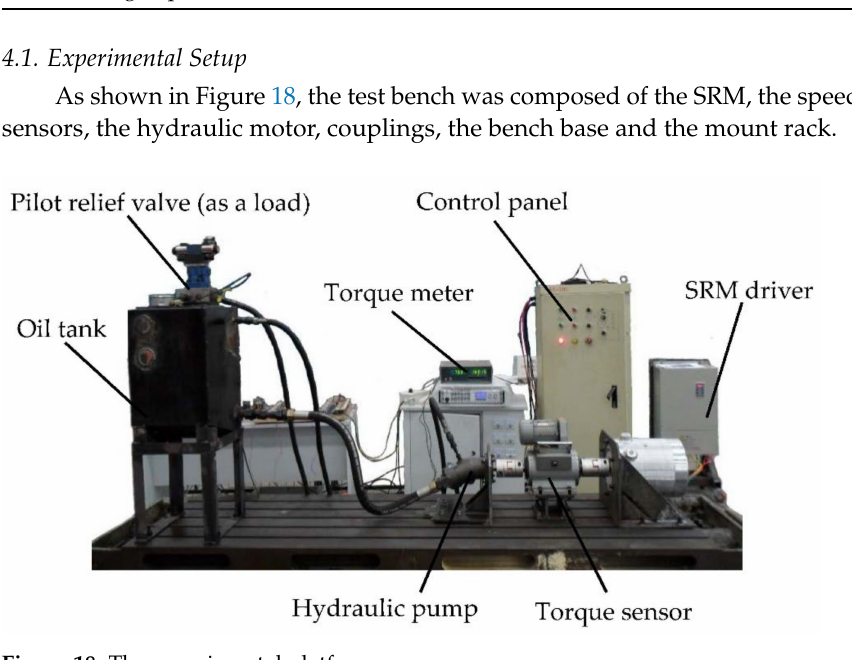
Figure 18. The experimental